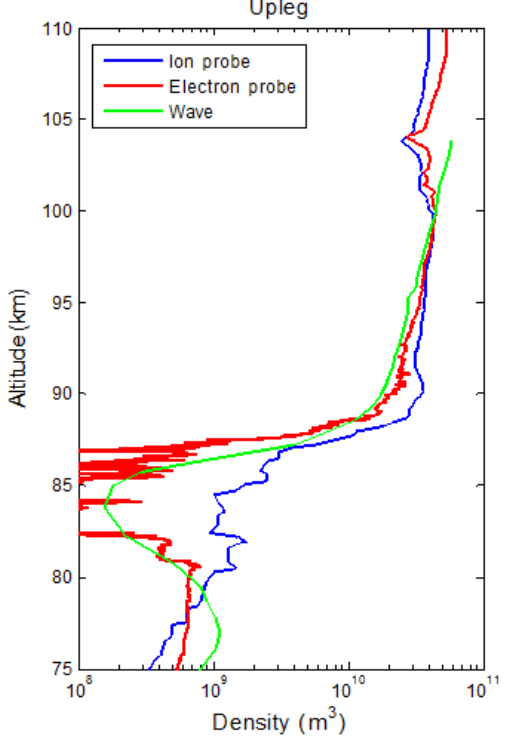
Figure 11. Plasma density measurements during upleg of the WADIS-1 rocket flight. The green line shows absolute electron den- sities measured with the radio-wave propagation experiment. The blue and red lines are for ion and electron densities,